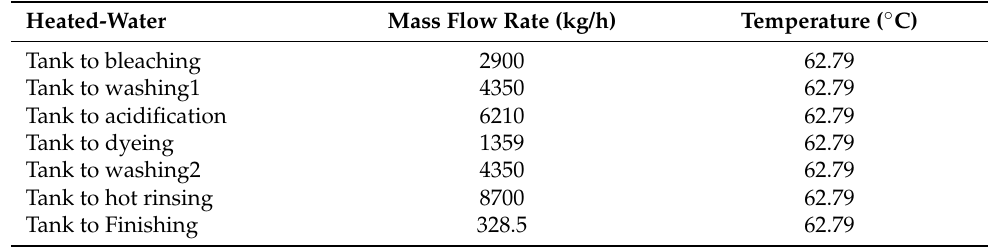
Table 6. Flow rate and temperature of heated-water (Case 2).